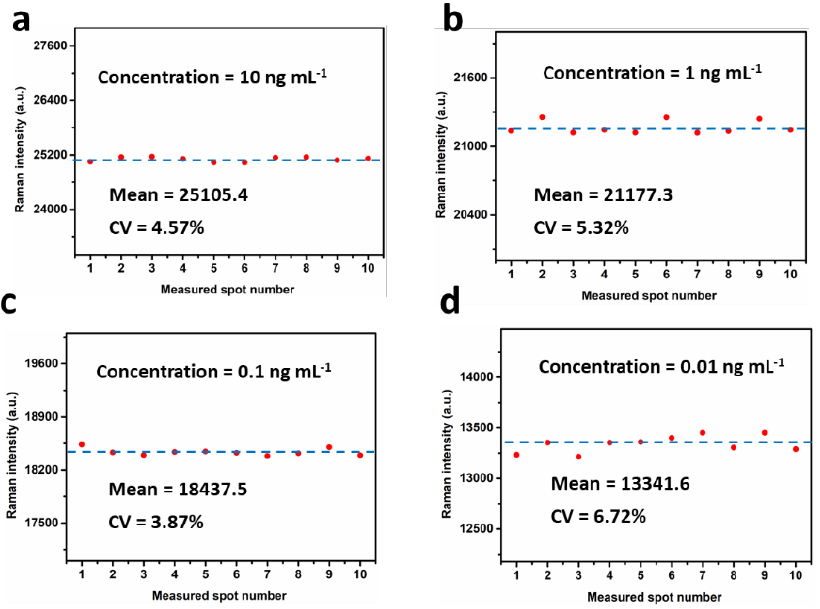
Figure 6. The SERS intensity of Au 4-MBA @Ag at 1076 cm − 1 from ten different spots in the center part of the test spot with concentrations of ( a ) 10 ng mL − 1 , ( b ) 1.0 ng mL − 1 , ( c ) 0.1 ng mL − 1 , and ( d ) 0.01 ng mL − 1 , respectively.